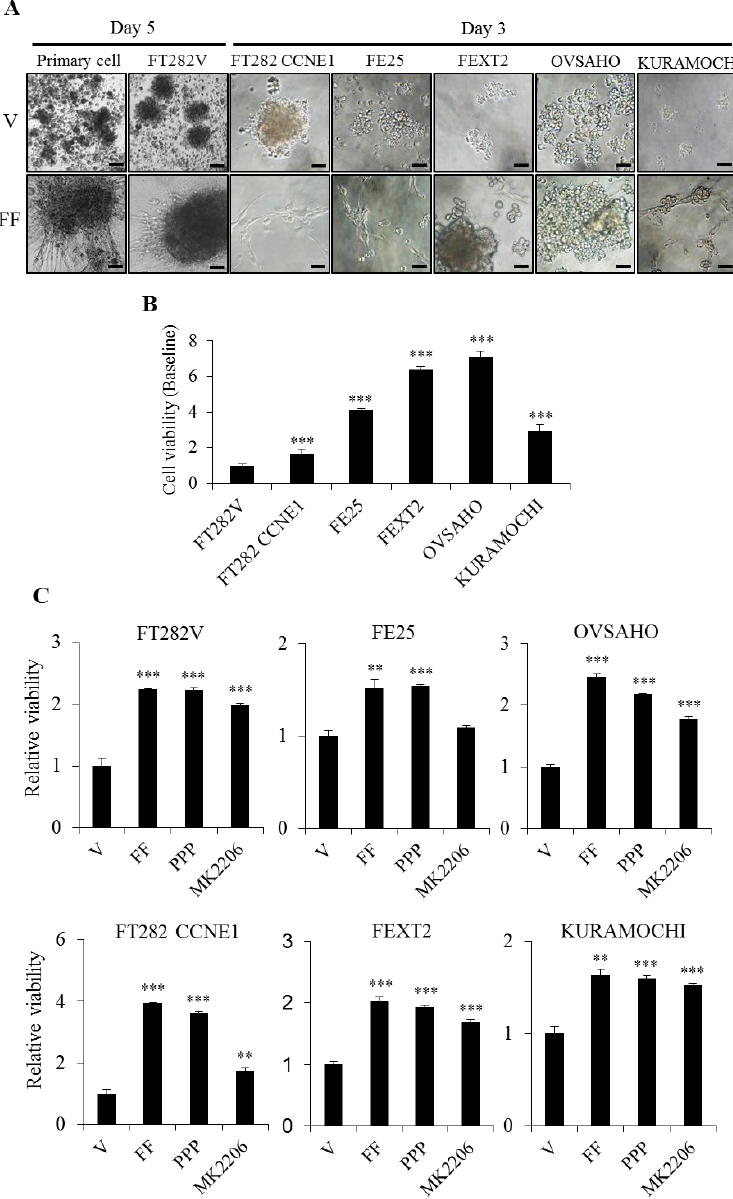
Figure 4. FF increases anoikis resistance in transforming FTE /HGSC cells, partly conferred by AKT. ( A ) Under serum-free conditions, cell attachment was first tested on the ultra-low attachment hydrogels with vehicle (V) or 10% FF for three or five days. Representative pictures showed remarkable cell adhesion and spreading of all cells tested after FF treatment. Scale bar, 50 μm. ( B ) In the modified anoikis assay, we used 0.4% agarose to incubate 4 × 10 3 cells in ultra-low attachment plates for 3D suspension culture and used XTT colorimetry to detect cell viability after 24 h. Survival of FT282-V was used as the reference to compare survival of different cells. ( C ) Relative cell viability was compared in the same cell panel with or without IGF-1R/AKT inhibitor pretreatment and FF/vehicle treatment. Assays were performed in triplicates. The error bar represents mean ± SD ( n = 8), the asterisk represents comparison of vehicle treatment. ** p < 0.01, *** p < 0.001 by two-sided, unpaired Student’s t -test.